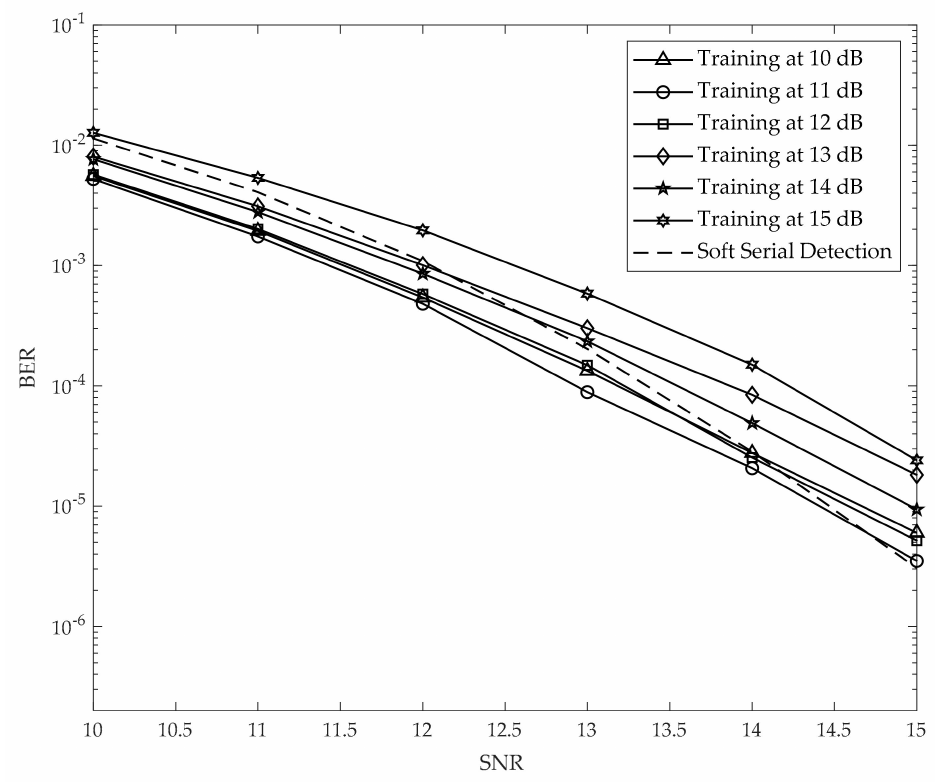
Figure 10. The BER performance of serial detection with one hidden layer neural network.